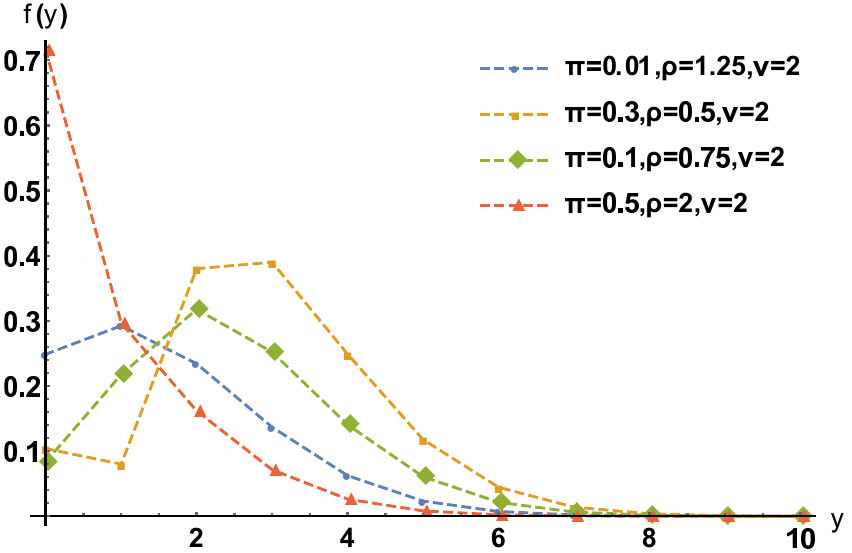
Figure 1 – Plots of probability mass functions of ZIAHPD for different values of π and ν .